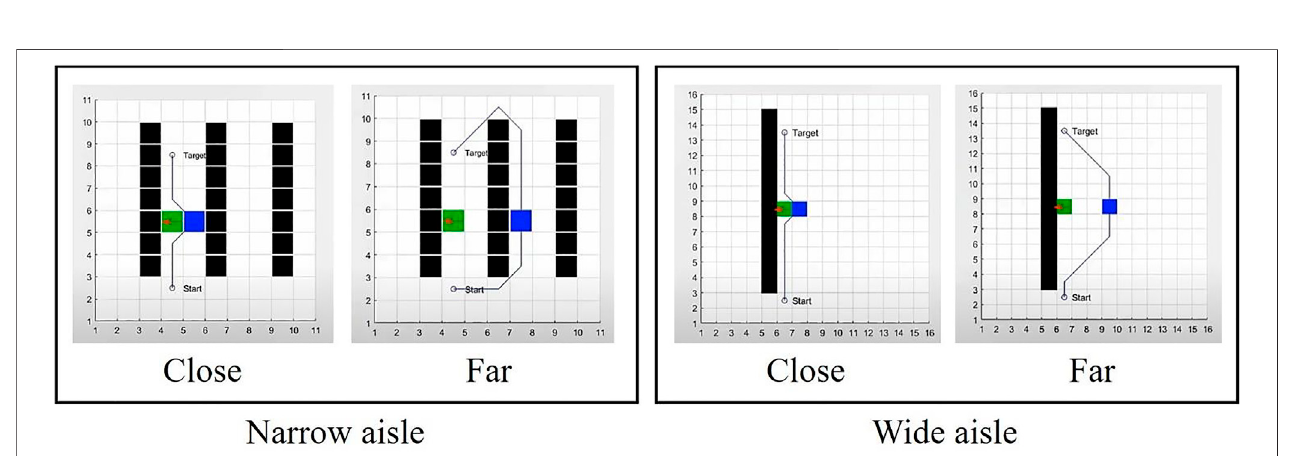
FIGURE 3 | Screenshots of the 2D simulation